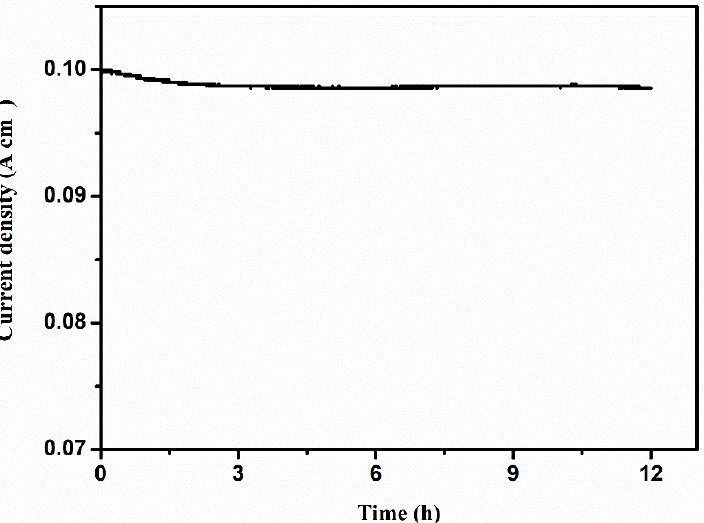
Figure 9. The stability performance of a core-shell NiCo 2 O 4 @NiCo 2 O 4 /NF composite at 100 mA/cm 2 .